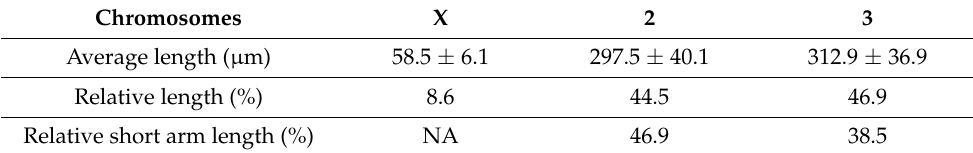
Figure 1. A chromosomal complement of a squashed preparation of salivary gland cells of Anopheles daciae with karyotype X01, 2R00, 2L00, 3R01, and 3L00 stained by orcein where X, 2R, 2L, 3R, and 3L represent chromosome armes. Heterozygous inversion variants X01 and 3R01 are seen as loops in the chromosomes. CC stands for the chromocenter. Chromosome X and chromosome arms 2R, 2L, 3R, 3L are indicated. Scale bar equals 20 μ m. Table 1. Measurements of the polytene chromosomes from An. daciae salivary gland cells.